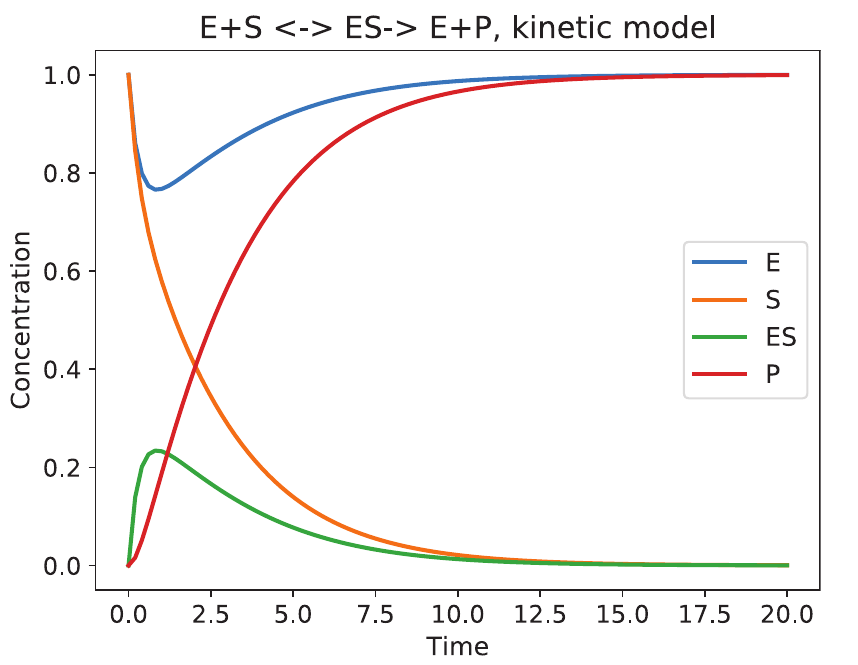
Fig 2. Reaction kinetics of an enzyme-substrate system with rate constants k f = k r = k c = 1 and initial concentrations E = S = 1 and ES = P = 0. The simulation is the solution of the underlying ordinary differential equation, and the concentrations of the species are therefore still 2 R considered to be the underlying truth that our algorithm tries to recreate with an automatically generated Boolean logic network.